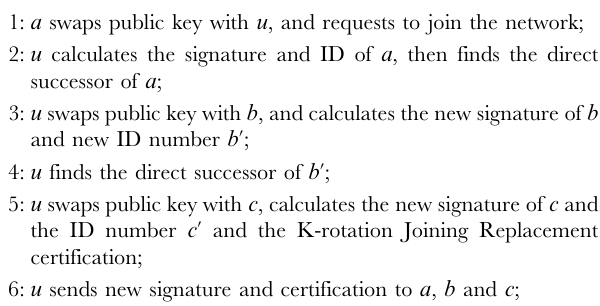
Algorithm 1 the K-rotation Joining Algorithm.